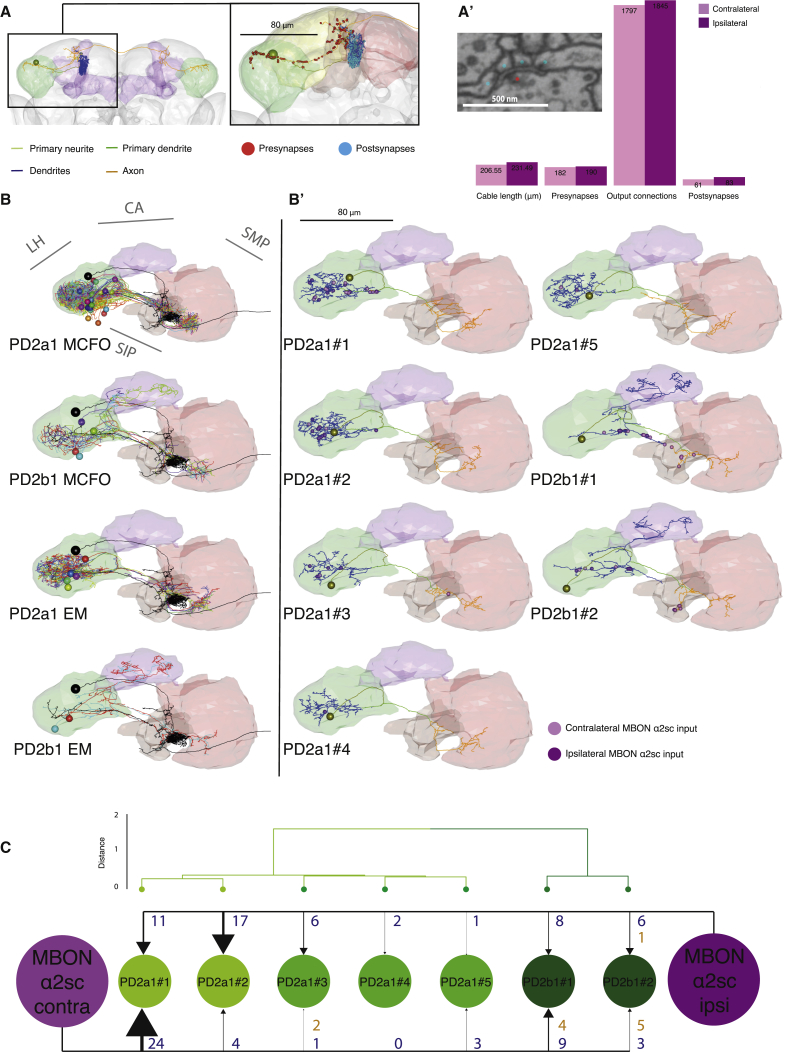
Electron Microscopy Reconstruction of PD2a1 and PD2b1(A) Reconstruction of the right-side MBON-ɑ2sc in a whole brain EM volume. The cell body is represented as a sphere, and the primary neurite (yellow-green), primary dendrite (green), dendrite (blue), and axon (orange) compartments are separately colored. Neuropils: LH in green, MB in purple. Inset: position of presynapses (red spheres) and postsynapses (cyan spheres) on the right-side MBON-ɑ2sc. Neuropils: SLP in yellow, SIP in orange, SMP in red.(A’) Comparison of different metrics for the reconstructions of the contralateral and ipsilateral MBON-ɑ2sc within the LH (green in A). Inset: example of a polyadic synapse with a single T-bar (red dot) and multiple postsynapses (blue dots), referred to as “output connections” in the bar chart. Scale bar, 500 nm.(B) Dorsal view of co-registered PD2a1 and PD2b1 MCFO data (top two panels, respectively) and EM reconstructions (bottom two panels, respectively). Cells are individually colored. Ipsilateral MBON-ɑ2sc is shown in black.(B’) Dorsal view of single PD2a1 and PD2b1 neurons reconstructed in the EM volume. Yellow-green spheres represent somata, whereas ipsilateral and contralateral MBON-ɑ2sc synaptic connections are represented in dark and light purple, respectively.(C) Schematic of synaptic connectivity from the two MBON-ɑ2sc neurons onto each PD2a1 and PD2b1 cell. The PD2a1 and PD2b1 cells are clustered according to the NBLAST score of their axons and dendrites, identifying two main groups, PD2a1 and PD2b1. Numbers beside each arrow indicate the number of outgoing connections made onto PD2a1 and PD2b1 neurons dendro-dendritically (blue) and axo-axonically (orange). Contra, contralateral; ipsi, ipsilateral; LH, lateral horn; CA, mushroom body calyx; SIP, superior intermediate protocerebrum; SLP, superior lateral protocerebrum; SMP, superior medial protocerebrum.See also Figures S7 and S8.